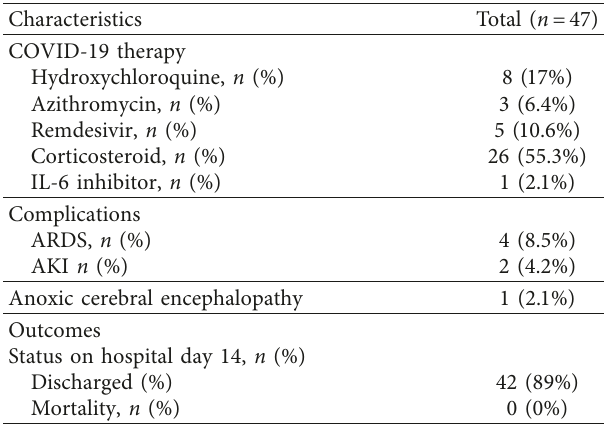
Table 2: Selected treatment and outcome characteristics of hos- pitalized